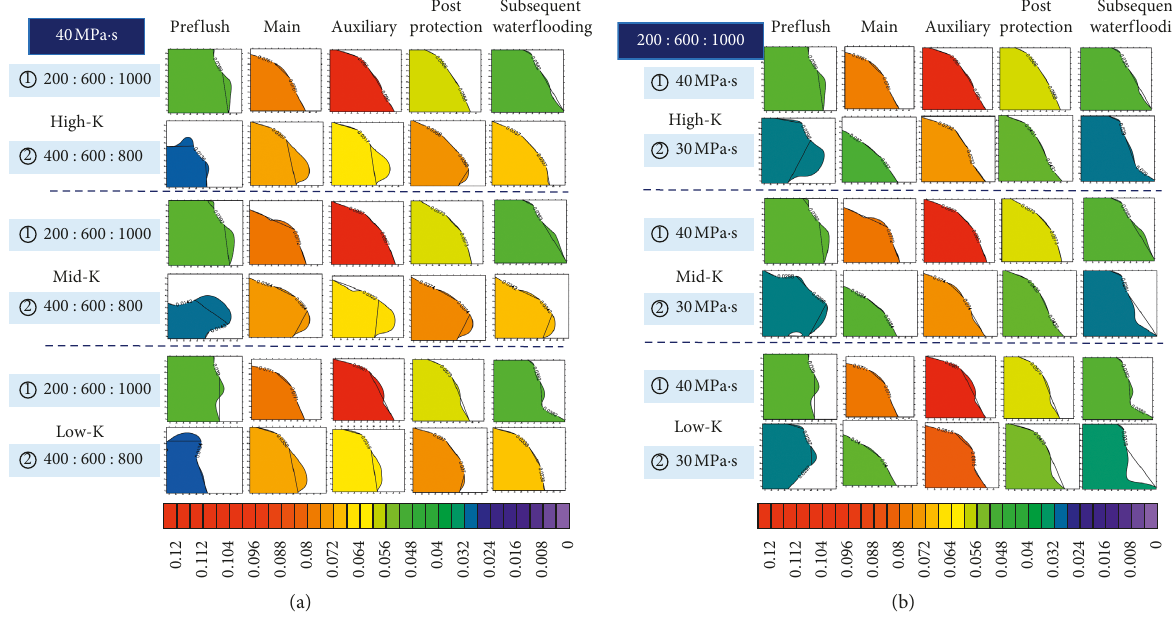
Figure 19: Average pressure front of (a) different heterogeneities and (b) different